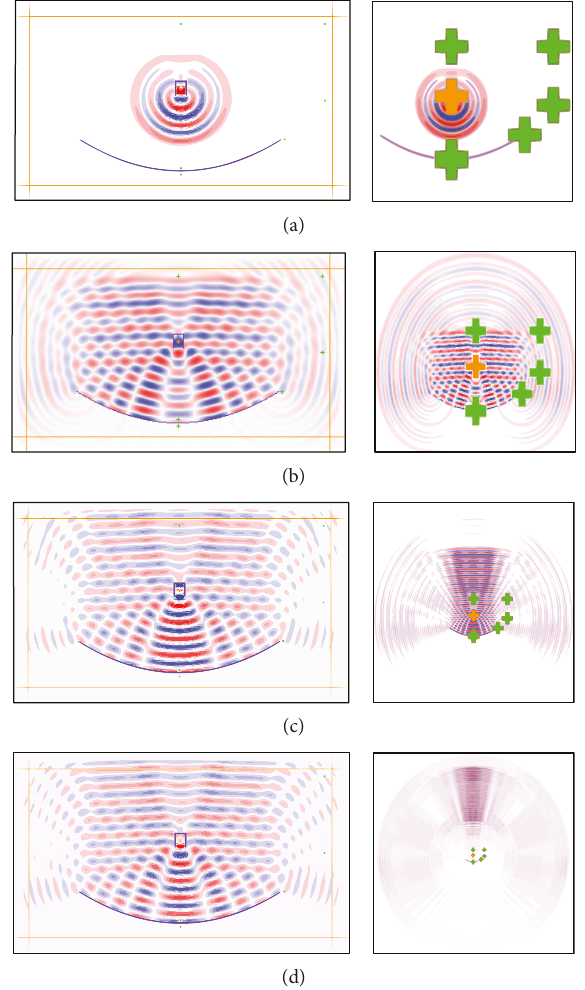
Figure 10: Distribution of electric fi eld ( E z ) for the parabolic plate experiment. At left, we observe the propagation in the CPML case, while at right, we show the reference solution. In (a), (b), (c), and (d), we present snapshots at n = 100 , 400, 750, and 1160 time steps. We observe an excellent absorption of waves in the CPML region, without the presence of spurious waves re fl ected within the physical domain. The simulation lasted n = 1160 time steps, and the source was turned o ff at n = 580